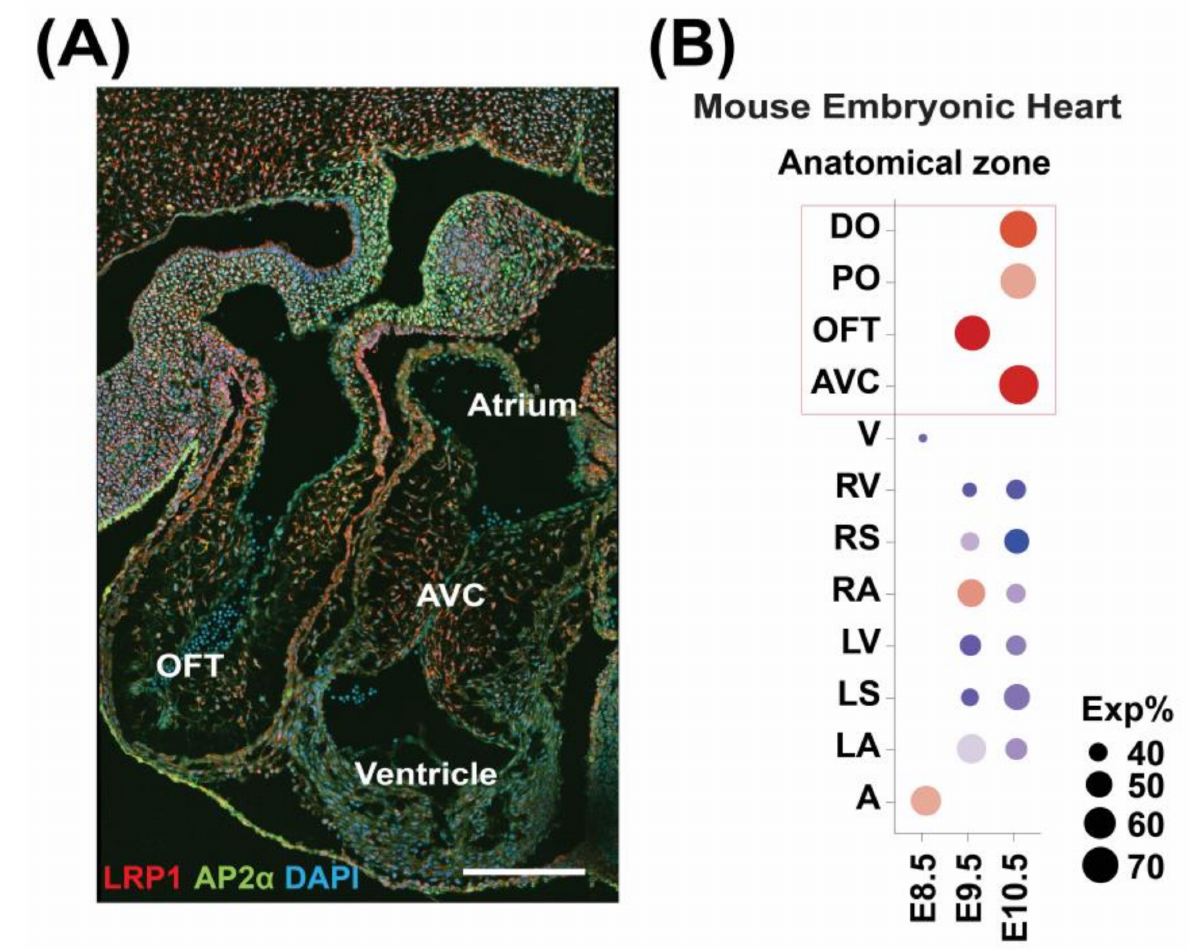
Figure 1. Spatiotemporal expression of LRP1 in the mouse developing heart. ( A ) Representative LRP1 immunostaining in the E10.5-11.5 mouse heart. AP2 α -activating protein transcription factor 2 alpha, a neural crest cell marker. DAPI-4 (cid:48) ,6-diamidino-2-phenylindole. Scale bar: 200 microns. ( B ) Expression of Lrp1 in dissected zones from mouse embryonic heart (from Li et al., 2016, a total of 2407 cells [4]). A-atrium, AVC-atrioventricular cushion, DO-distal outflow tract, LA-left atrium, LS-left ventricular septum, LV-left ventricle, OFT-outflow tract, PO-proximal outflow tract, RA-right atrium, RS-right ventricular septum, RV-right ventricle,